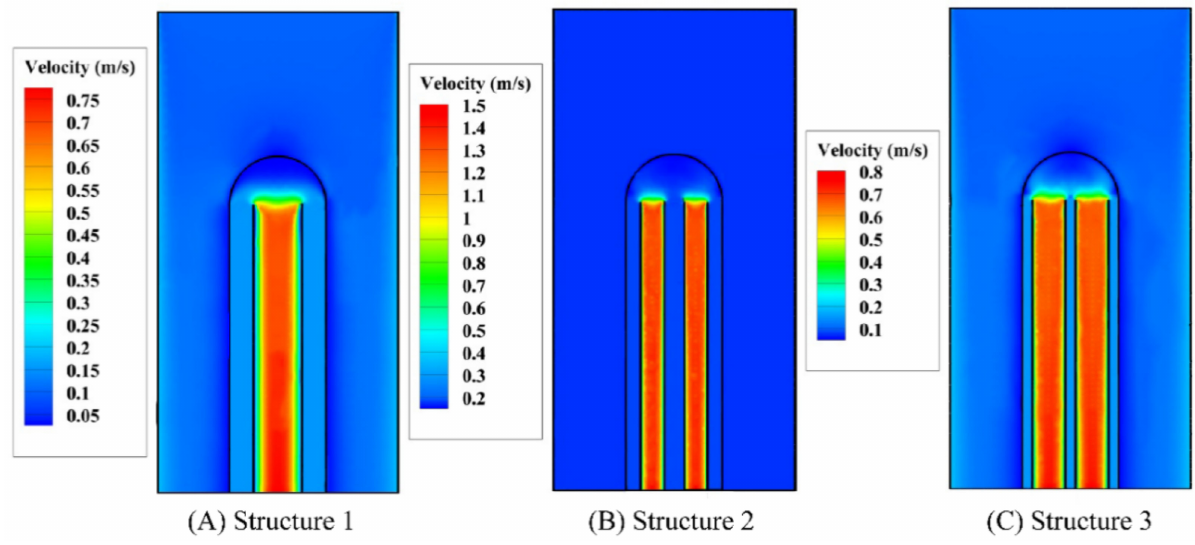
Figure 7. Velocity distribution in the bayonet heat exchanger for an inlet flow rate of 0.00035 kg/s. ( A ) Structure 1, ( B ) Structure 2, ( C ) Structure